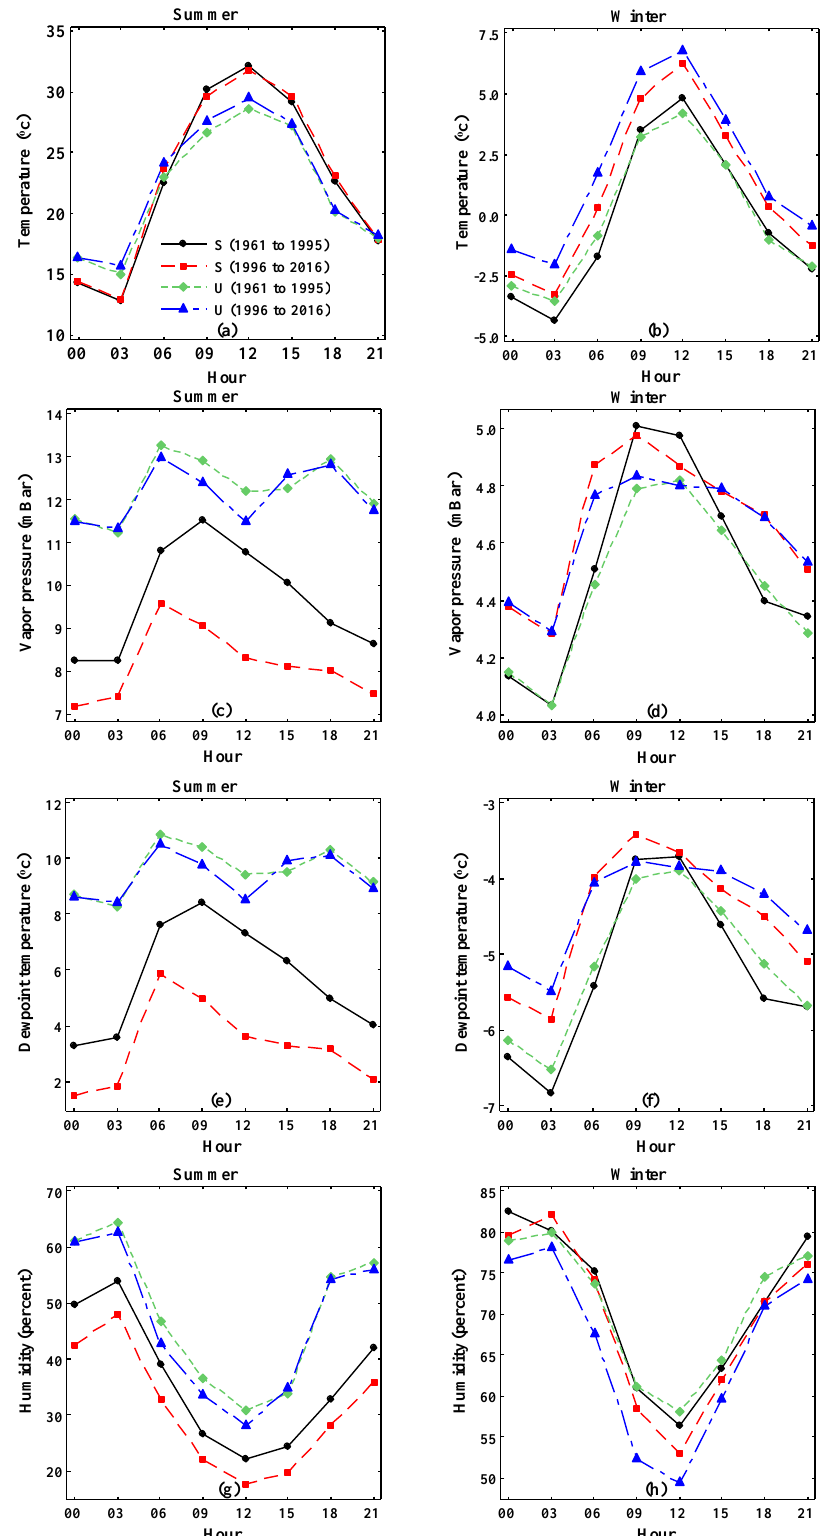
Figure 10. Hourly values of climate parameters at Urmia (U) and Saqez (S) meteorological stations in periods with normal (1961–1995) and low (1996–2016) lake level: ( a ) temperature in summer, ( b ) temperature in winter, ( c ) vapor pressure in summer, ( d ) vapor pressure in winter, ( e ) dewpoint temperature in summer, ( f ) dewpoint temperature in winter, ( g ) relative humidity in summer, and ( h ) relative humidity in